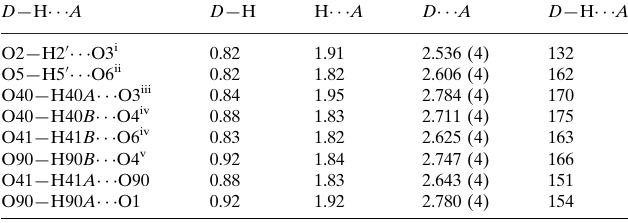
Hydrogen-bond geometry (A˚ , (cid:3) ). D —H (cid:2)(cid:2)(cid:2)